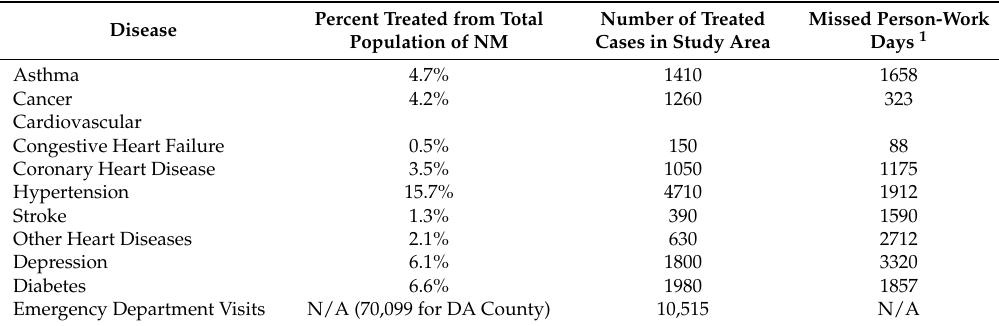
Table 5. Prevalence of selected chronic diseases in study area and related absenteeism from work (from